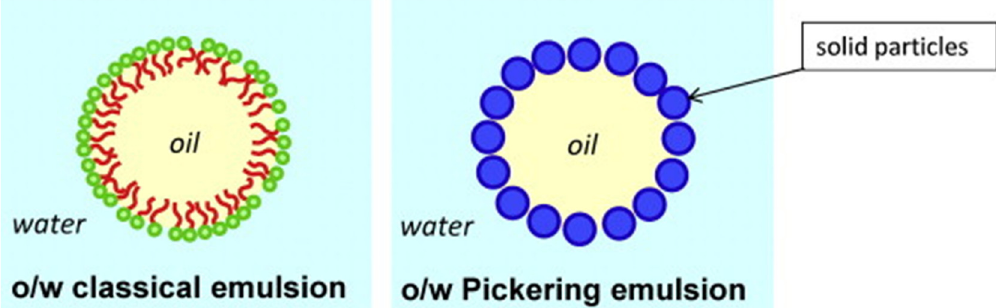
Figure 1: Schematic diagram of classical ( surfactant based ) emulsion and Pickering emulsion [ 31 ] .